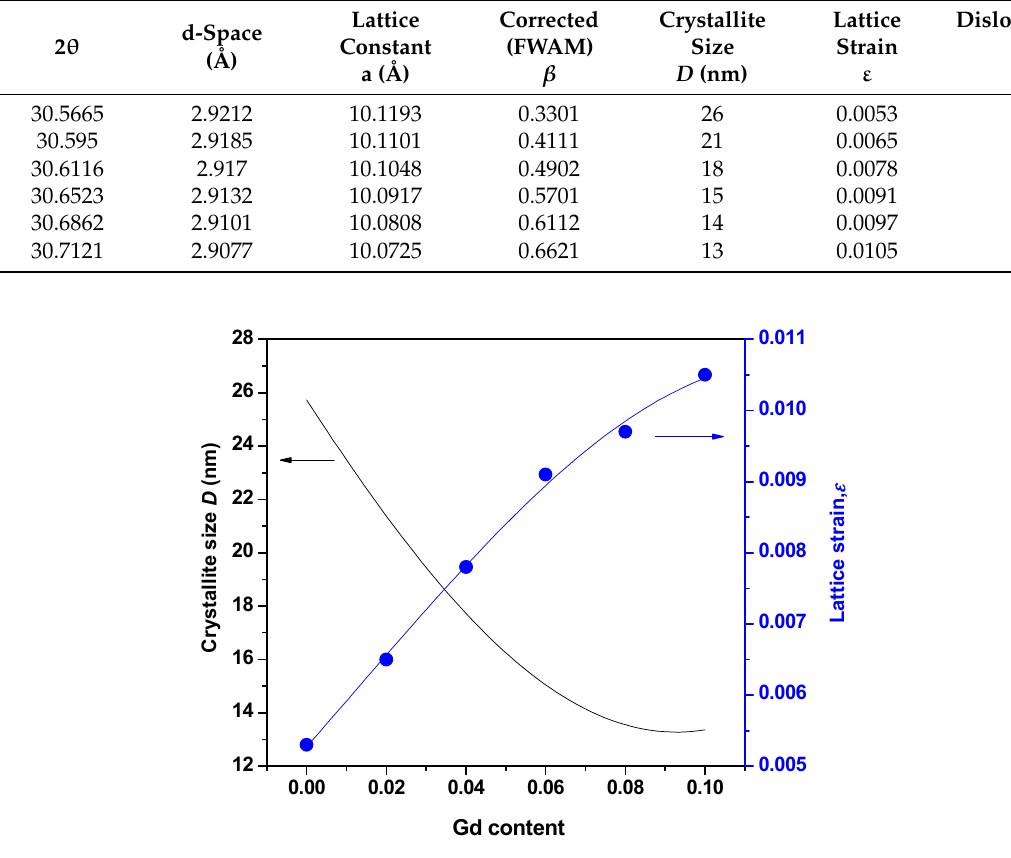
Figure 3. Variations in the lattice strain and crystalline size of (In 1 − x Gd x ) 2 O 3 films with the Gd content.